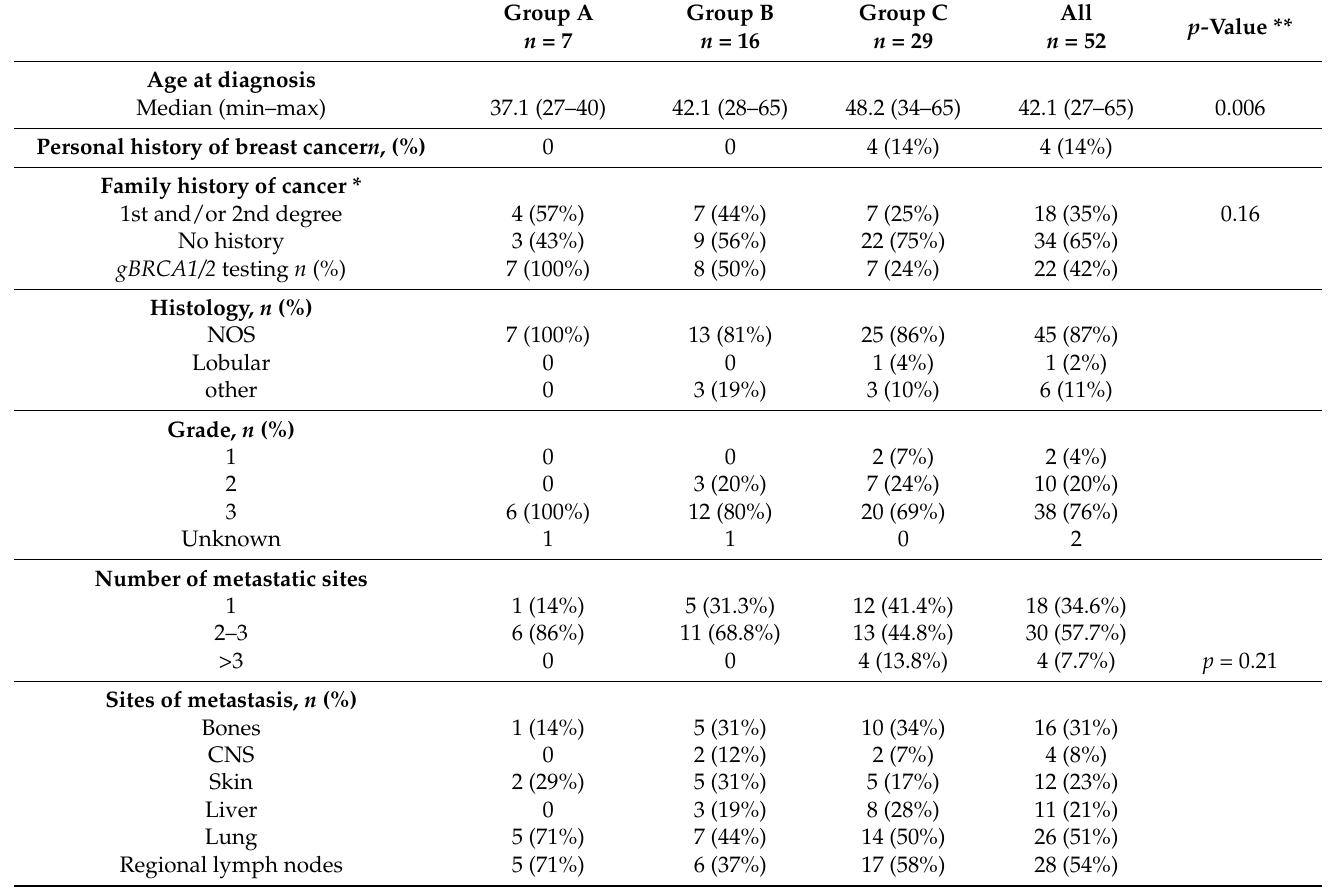
Table 1. Patient’s